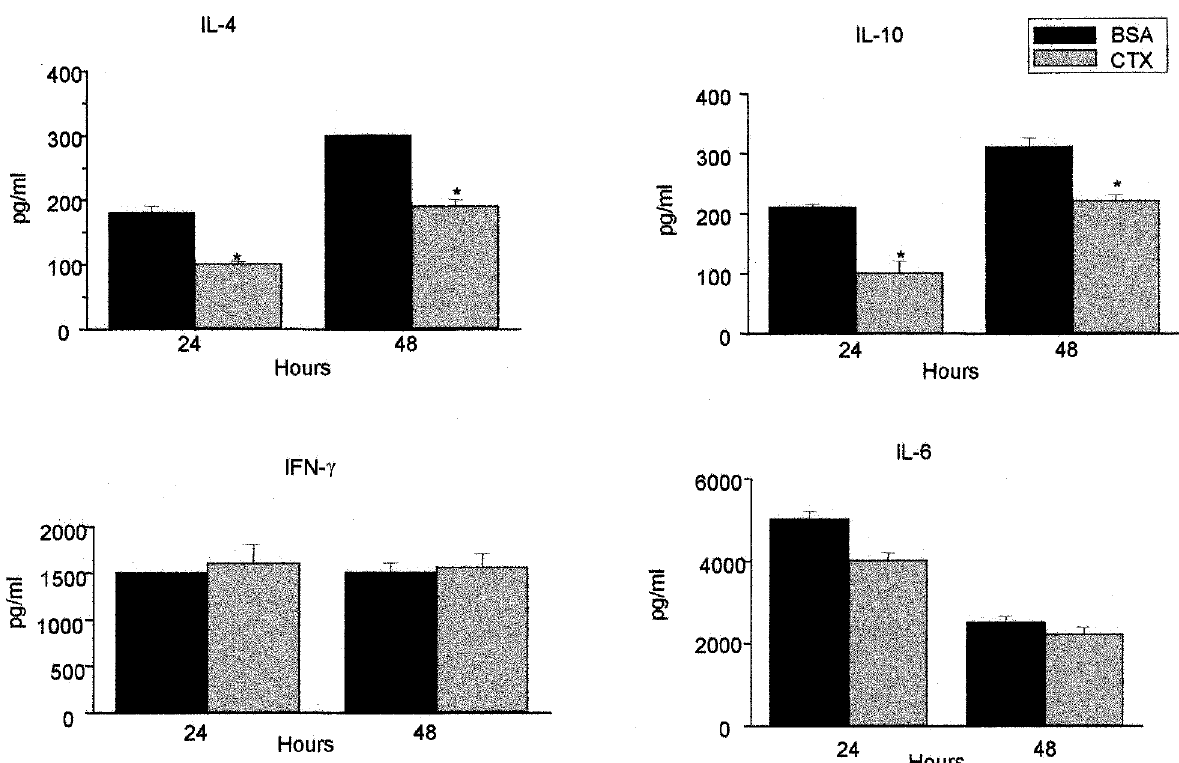
FIG. 3. Effect of in vivo crotoxin (CTX) treatment on cytokine secretion by spleen cells stimulated with concanavalin A (ConA). Spleen cells were collected from animals 6h after bovine serum albumin (BSA) ( j ) or CTX ( h ) treatment. A sample of 5 ´ 10 6 cells/well were stimulated with ConA (0.5ml of 10 m g/ml) during 24 or 48h at 37°C in an air chamber (5% CO 2 ). Cytokine contents were determined by enzyme-linked immunosorbent assay in cell supernatants. Values represent the mean of